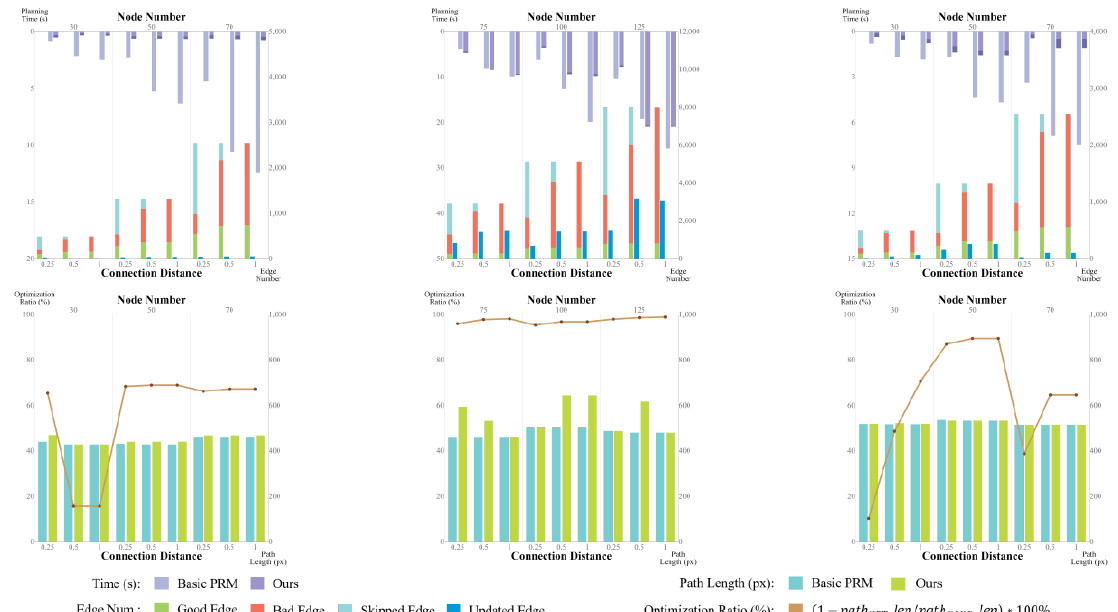
Figure 7 . Visualization analysis of experimental results. The first row is the result of planning time, the second row is the result of path length. From left to right are Map 1, Map 2 and Map